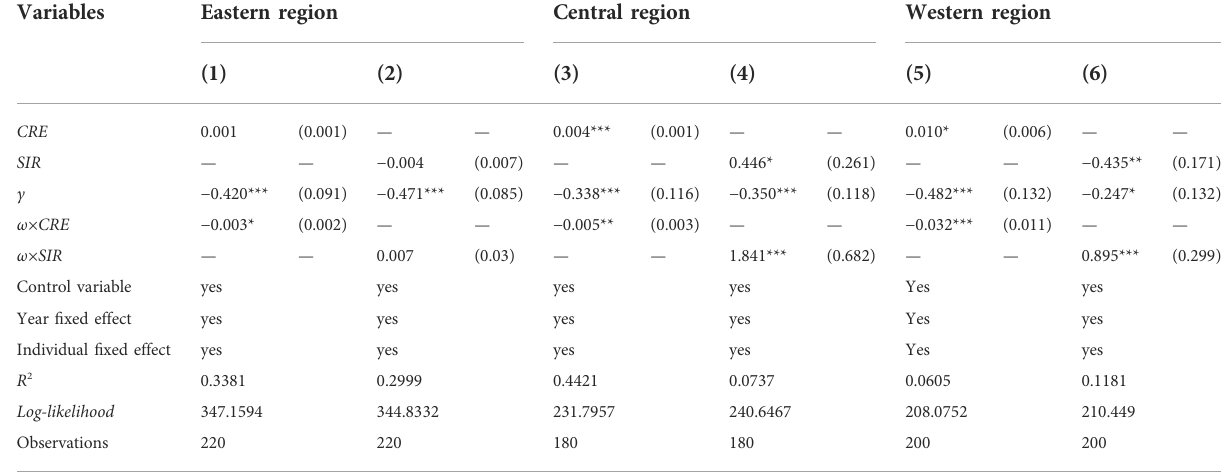
TABLE 7 Heterogeneity analysis of FRAE affecting